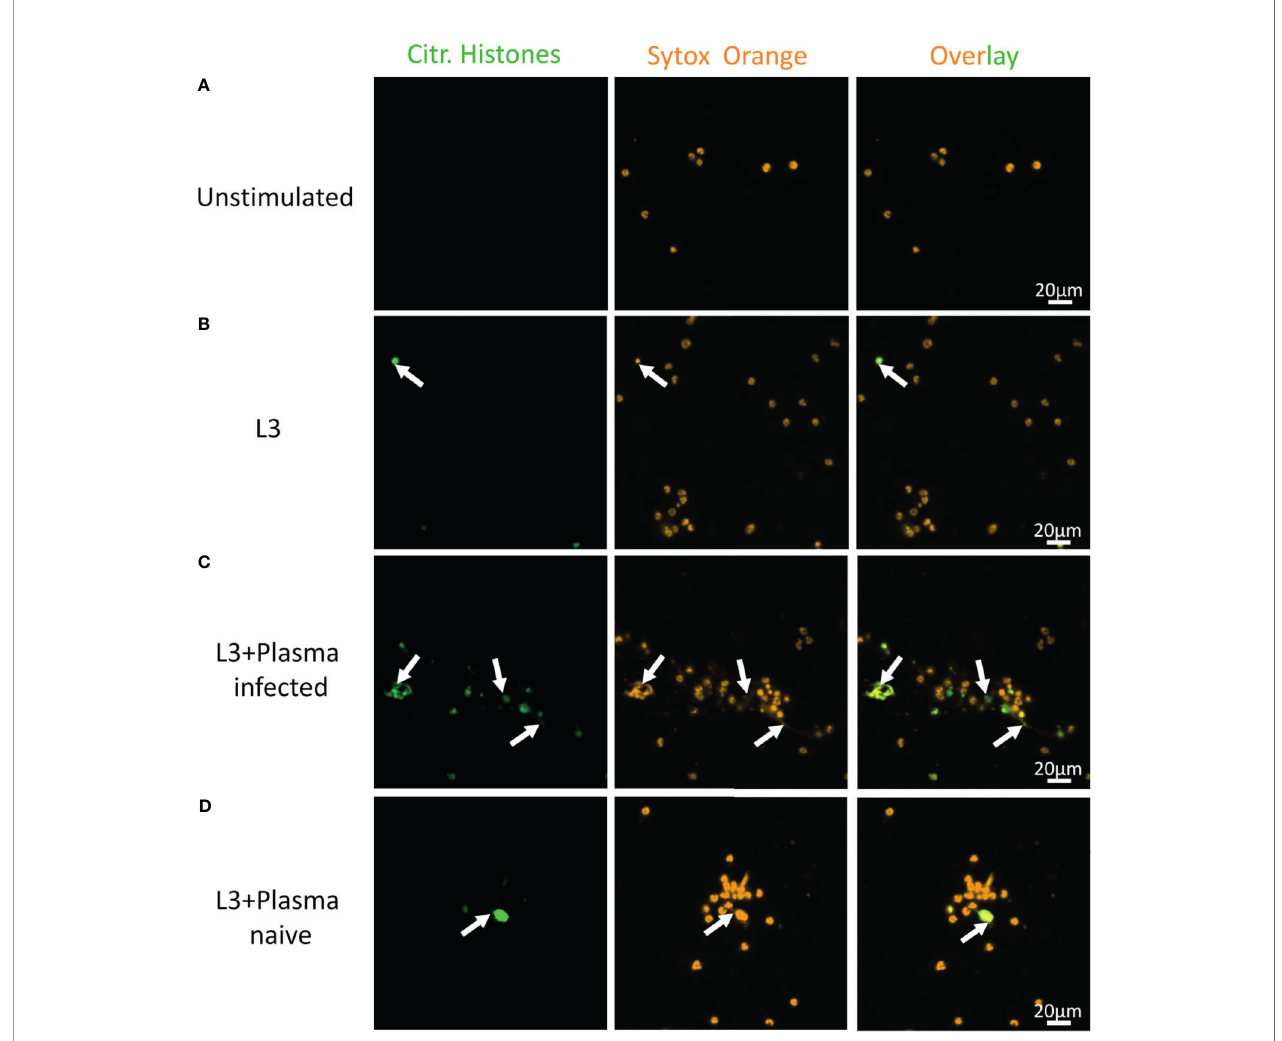
FIGURE 7 | S. ratti L3 and Ab induce EETosis. Representative fl uorescence microscopy pictures of eosinophils without stimulation (A) , stimulated with S. ratti L3 alone (B) or with plasma from S. ratti infected (C) or from naive animals (D) . Cells were stained for citrullinated histones (green, left pannel) and for DNA with Sytox orange (orange, middle pannel), right pannel shows the overlay. Shown is one out of two independent experiments with